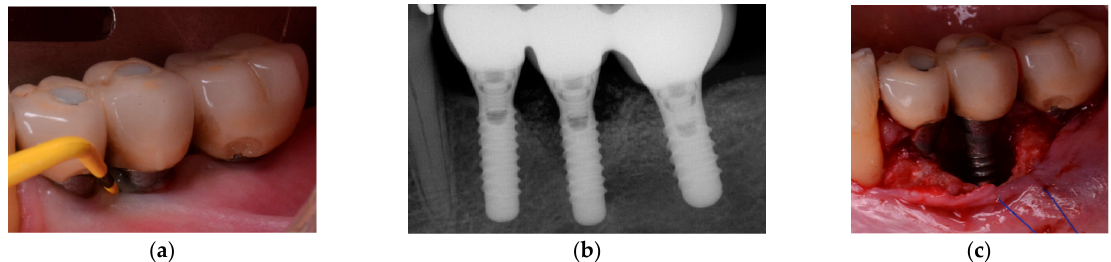
Figure 1. ( a ) Mandibular left premolar implant showing an increase in probing pocket depth as compared with previous